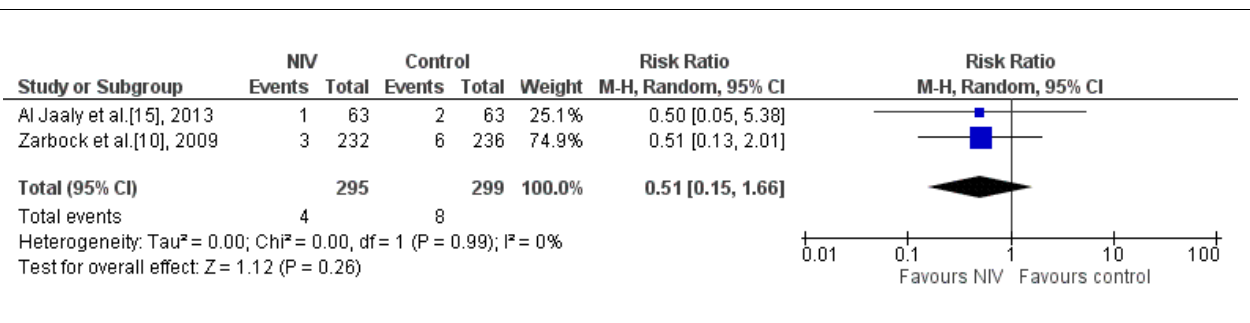
Fig. 4 – Analysis of the reintubation rate regarding the studies that compared the prophylactic NIV to the control group. NIV=noninvasive ventilation Length of Hospital